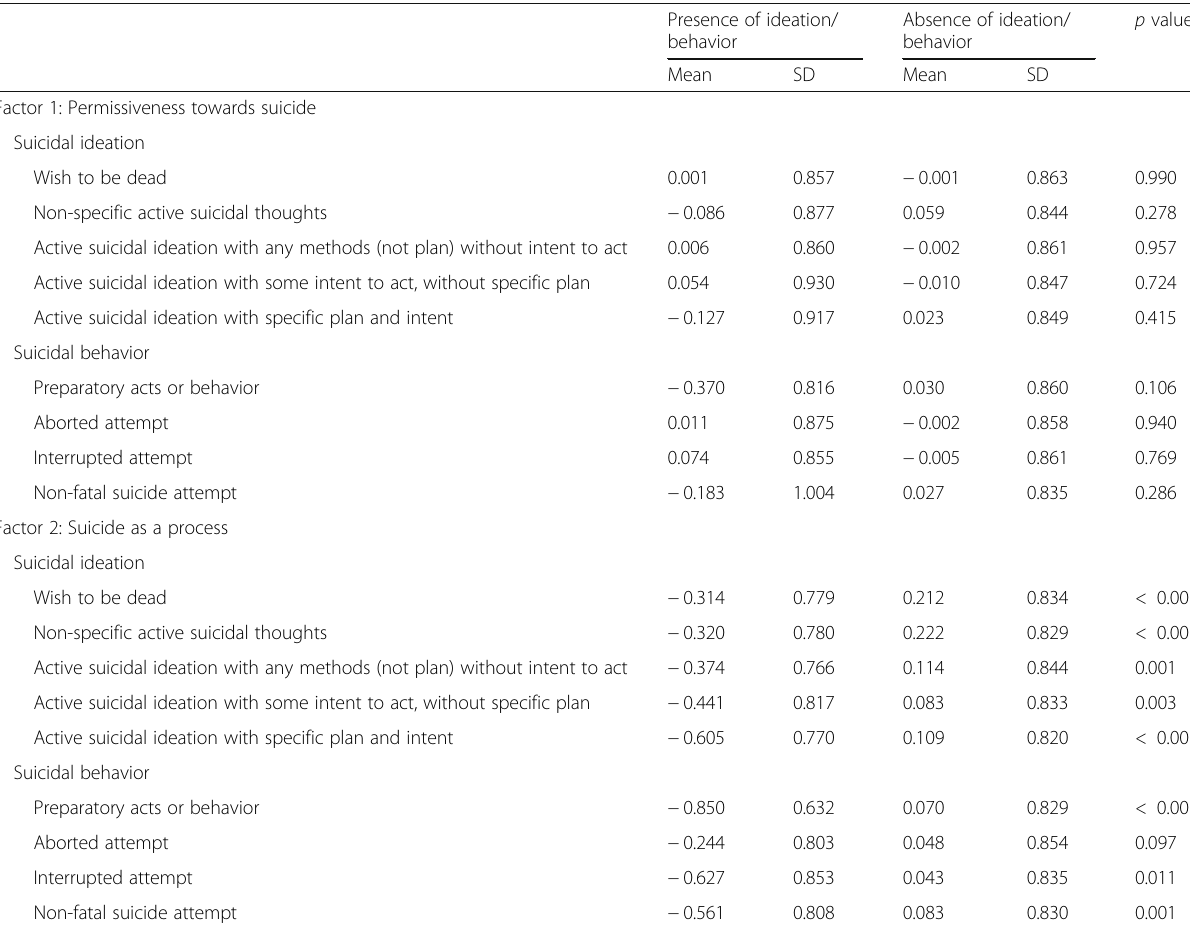
Table 6 Independent Sample t-test for mean factor scores on learners ’ attitudes towards suicide and lifetime suicidal ideation and